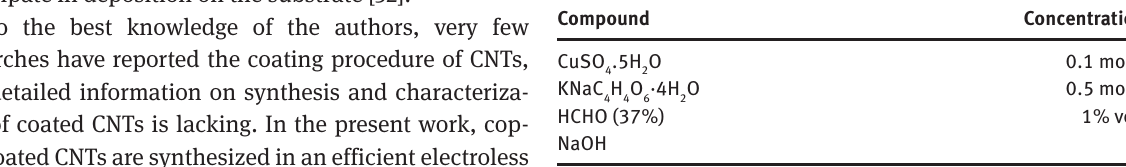
Table 1: Composition of copper electroless deposition bath.